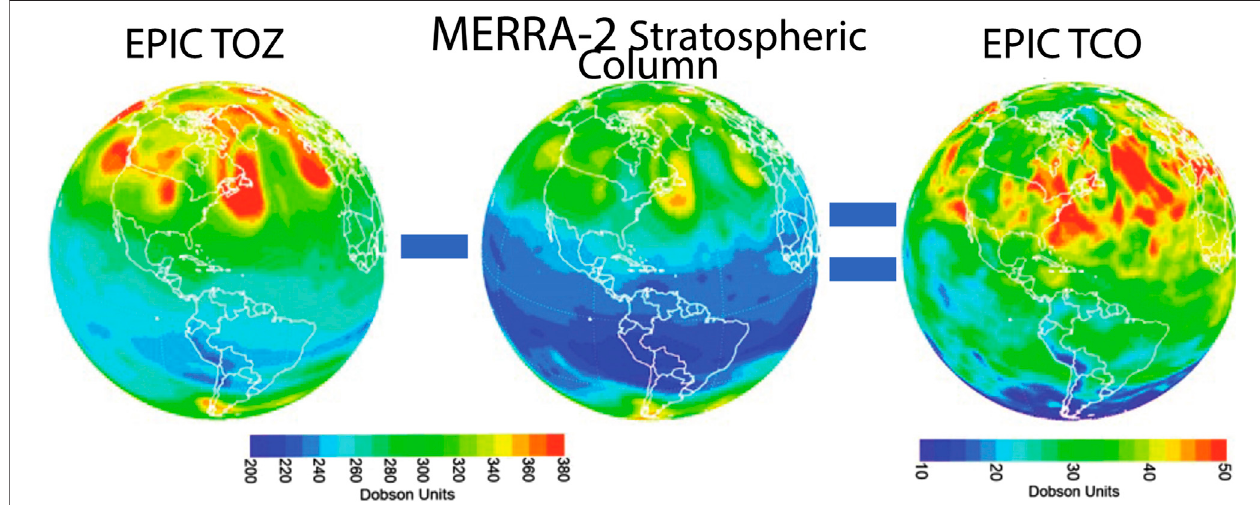
FIGURE4| Schematicillustrationoftheresidualsapproachforderivingtroposphericozonecolumns.TheleftplotshowsasynopticTOZmapderivedfromEPICon June 24, 2019. The center plot shows a map of stratospheric ozone column from MERRA-2 for the same time. The TCO is derived by subtracting MERRA-2 stratospheric column from